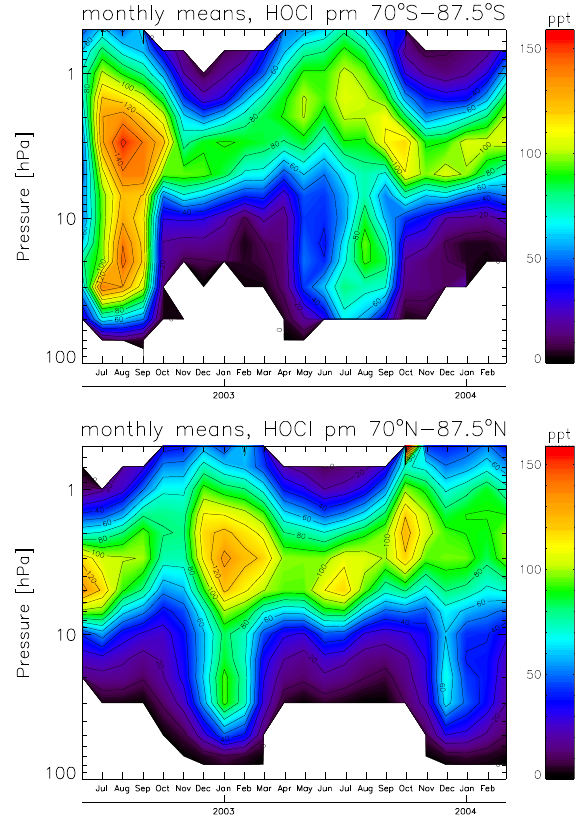
Fig. 9. Large HOCl amounts in the upper southern polar vortex are found in the southern winter 2002 (upper panel) when unusual planetary wave activity led to displacement, deformation, and split of the polar vortex, but not in 2003 (lower panel) when the polar vortex behaved normally. HOCl September zonal mean values of the descending part of the orbit, i.e. morning measurements, are shown.